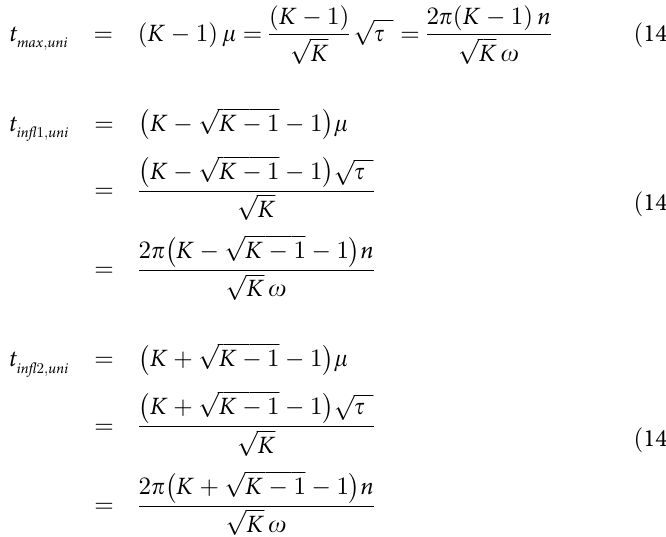
ffiffiffiffiffiffiffiffiffiffiffiffi